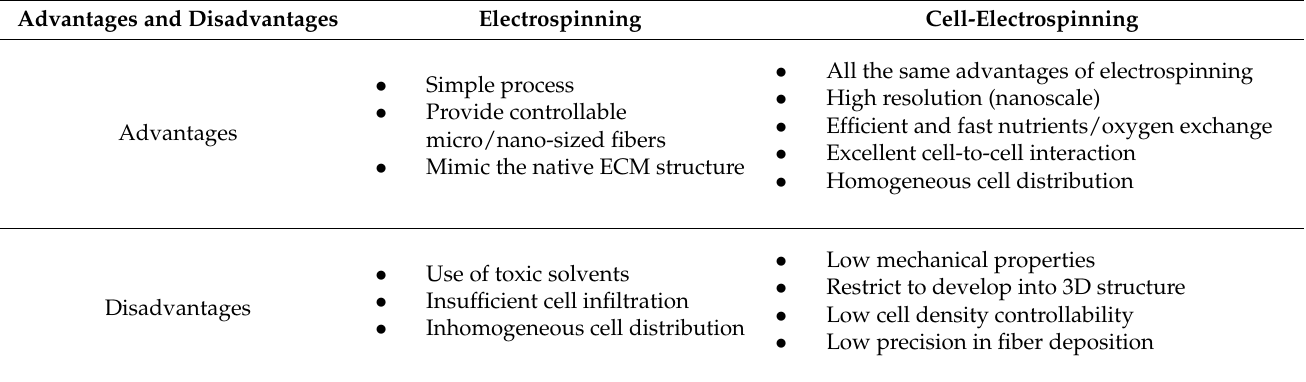
Table 3. Advantages and disadvantages of conventional electrospinning and